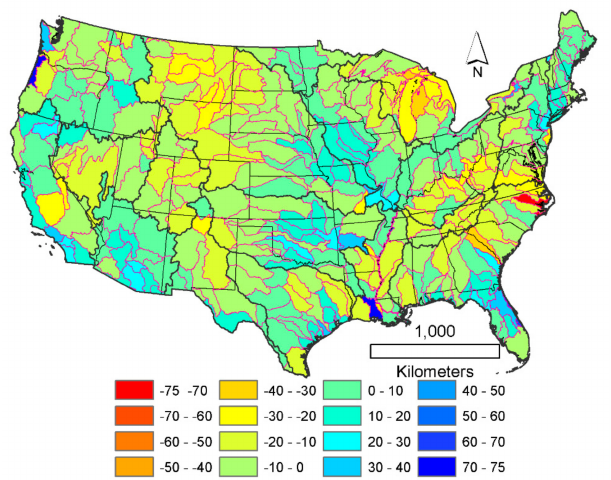
Figure 15. Spatial distribution of the estimation errors (mm dec − 1 ) in the linear tendencies for the HUC6 annual PRISM precipitation rates (1979–2015). The seven HUC6 basins with outlier streamflow rates (Figure 1) are left in the map for spatial